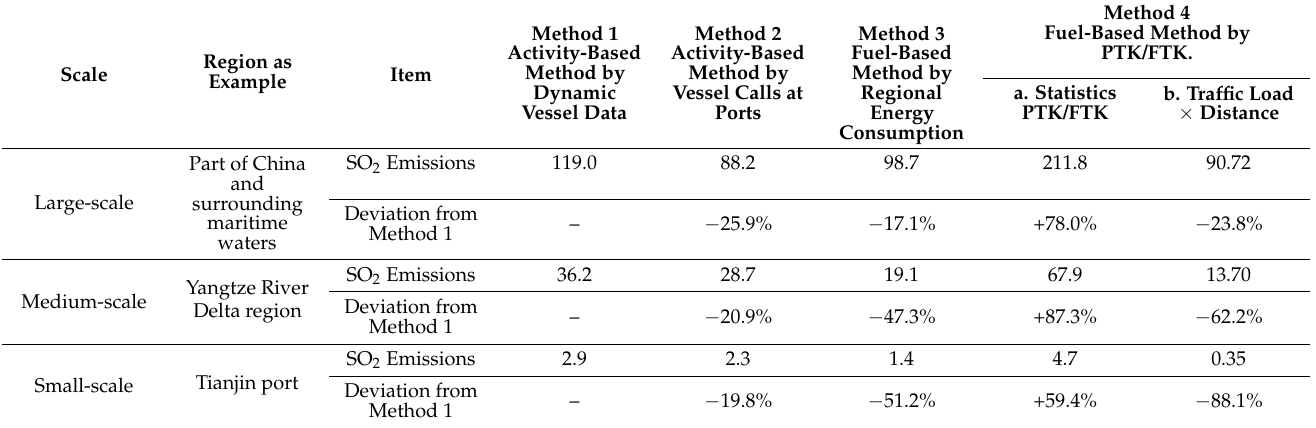
Table 6. Comparison of illustrative computed results by each method. Unit: 10 4